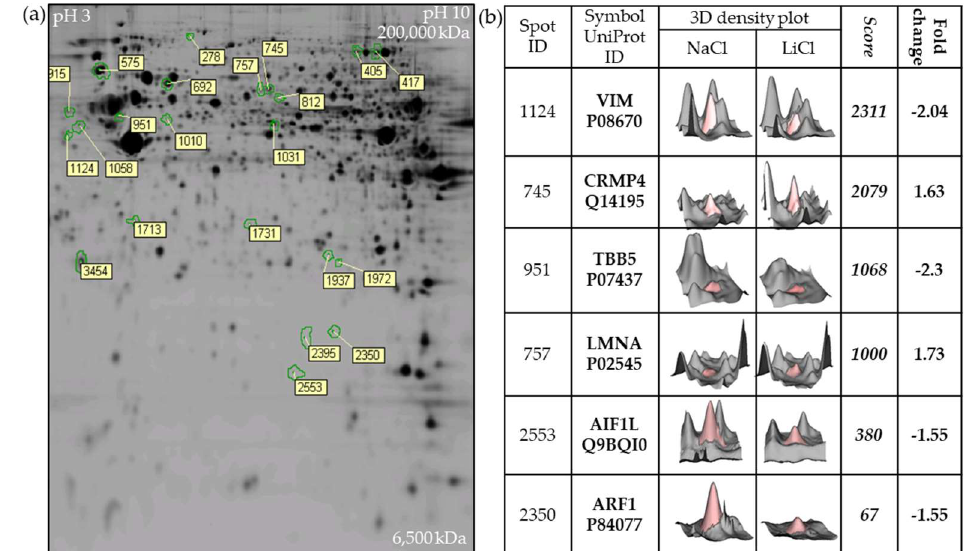
Figure 1. Two-dimensional fluorescence difference gel electrophoresis (DIGE) proteomics analysis identified 22 protein spots significantly altered by 20 mM lithium chloride (LiCl) treatment of glioblastoma (GBM) cells for 24 h. The experiment was performed in triplicate. ( a ) Representative Cy3/Cy5 stained (presented in gray) gel showing differentially regulated spots after 24 h treatment of U251 cells with 20 mM LiCl. ( b ) The top six targets were excised from the gel based on significance after analysis of alterations in fluorescence intensity post-LiCl treatment and identified by mass spectrometry peptide analysis.